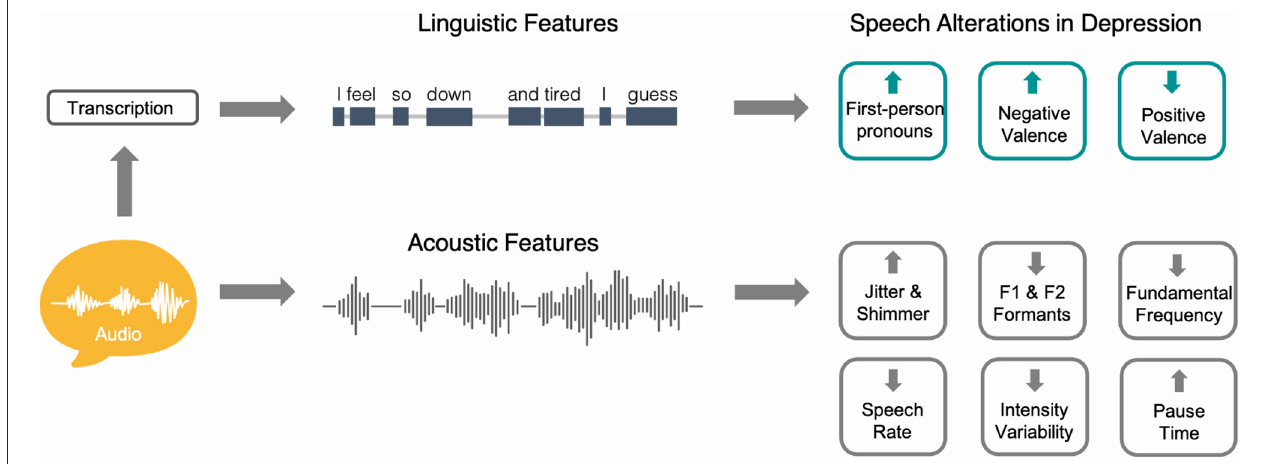
FIGURE 1 | Schematic representation showing how speech can be used to study linguistic and acoustic alterations in depression. To assess linguistic aspects of speech, audio samples are first transcribed using either manual or automatic speech recognition processes. Natural language processing methods can then be used to assess lexical, syntactic, and content measures of language. Audio waveforms can be directly analyzed to capture acoustic aspects of speech such as pause time, speech rate, and fundamental frequency. The right aspect of the figure shows examples of commonly reported speech alterations in the depression literature and the direction of these alterations compared to